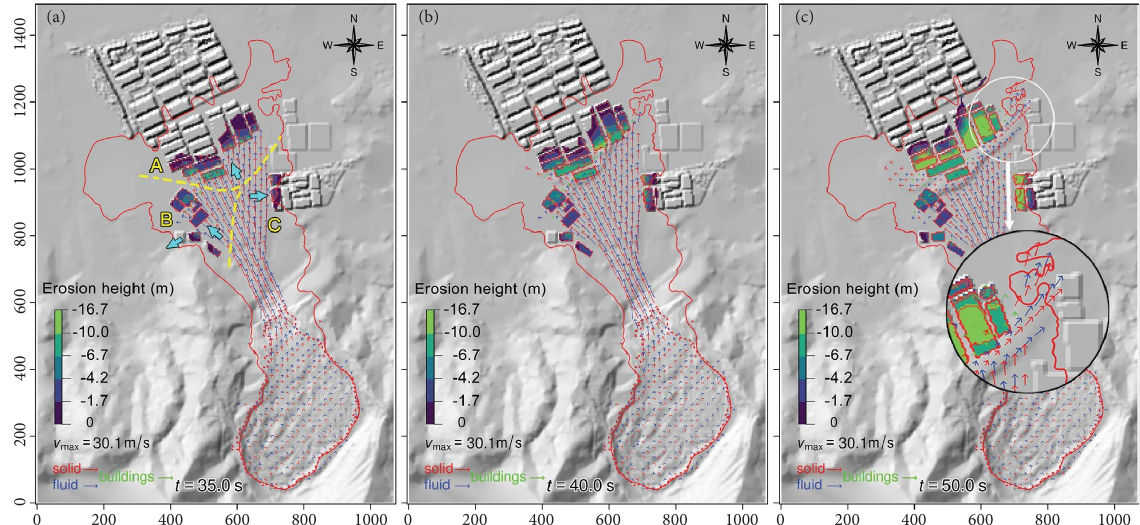
Figure 8: Evolution characteristics of the landslide erosion extent (eroded buildings are in light-green to dark-blue